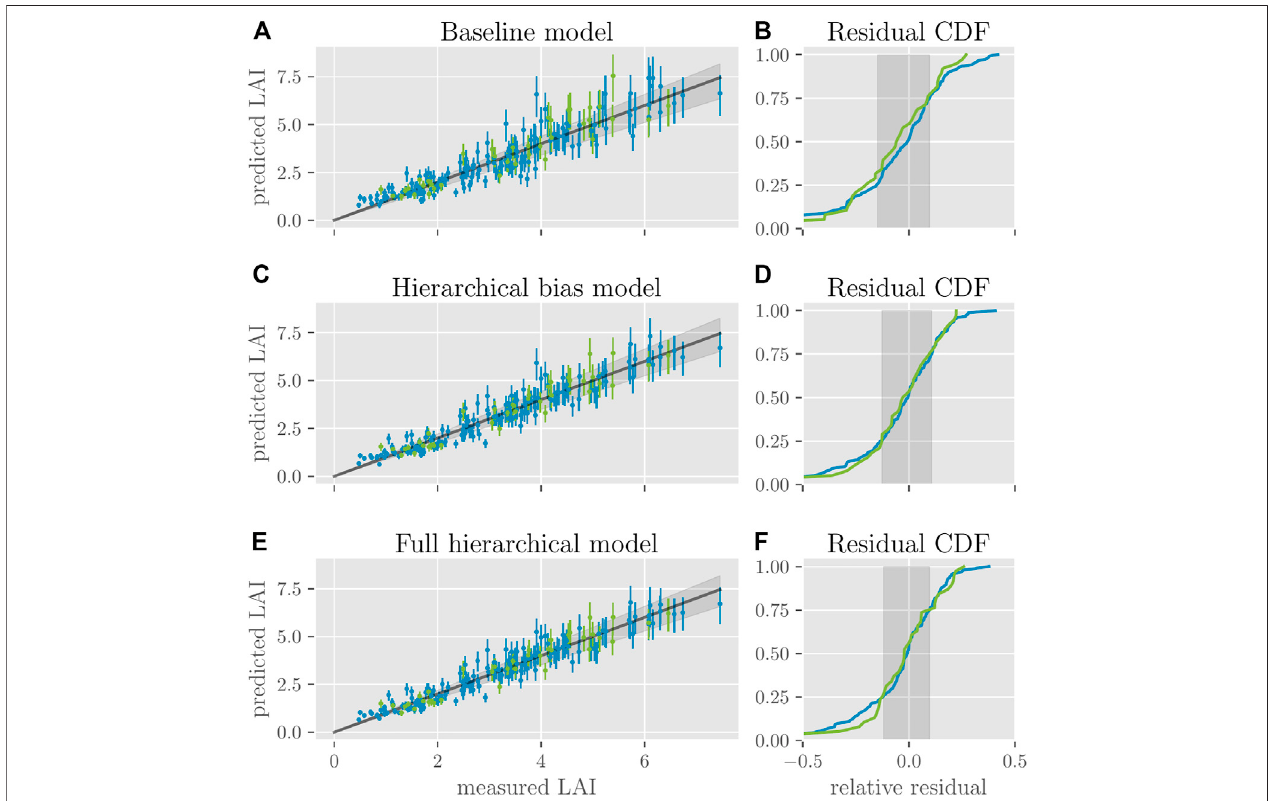
FIGURE5| ModelpredictionsofLAI.Forthethreemodels, (A) , (C) and (E) plotforeachdatapoint(trainingdatainblueandtestingdataingreen)thepredictedLAI valuesagainst themeasuredLAI values. Errorbars indicate the interquartile range ofthe predictive distributions.Dots representthe expected value. The gray line shows the optimal predictions; the best 50 % of model predictions lie within the gray cone around it. (B) , (D) , and (F) show the cumulative distribution function of the residuals, each normalized by thecorrespondingmeasuredLAI value for training and testing data (blueand green lines). The gray areas show thesameinterquartile range as the cones in (A) , (C) , and (E) .